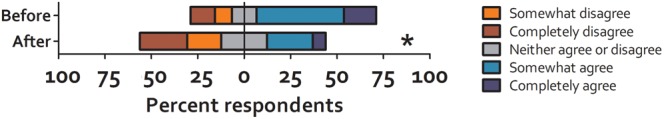
The completion of the survey instrument associated with a change of participants views of Learning Styles. At the beginning of the study, participants were asked to rate their agreement with the statement “I try to organize my teaching to accommodate different student Learning Styles (e.g., visual, kinaesthetic, assimilator/converger),” and 64% agreed. At the end of the study, participants were asked “In light of the information presented, rate your agreement with the following statement – ‘I plan to try and account for individual student Learning Styles in my teaching,”’ and 32% agreed. ∗, a Wilcoxon signed rank test revealed a statistically significant difference in the pattern of response (P < 0.0001, W = -1977).